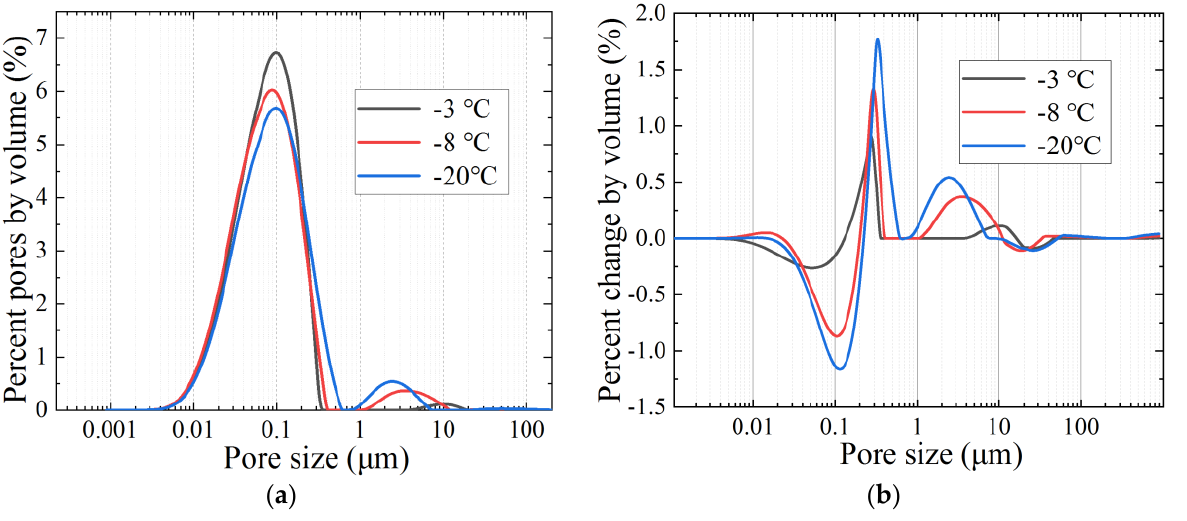
Figure 7. Effect of freezing temperature: ( a ) pore size distribution; ( b ) differences in the pore size distribution.